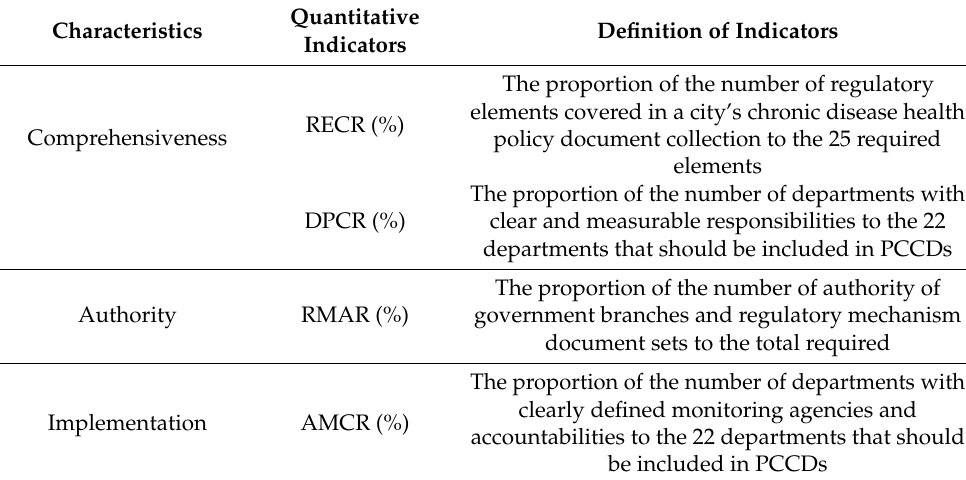
Table 1. Evaluation indicators for the soundness of